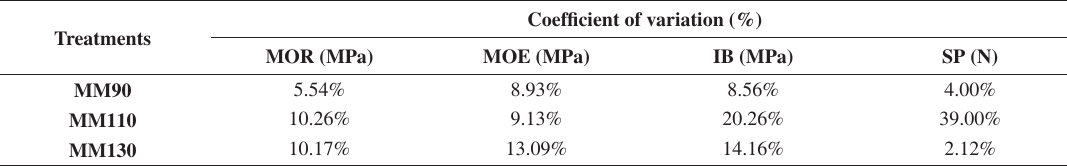
The same letters indicate that the treatments did not differ statistically after the one-way ANOVA followed by the Tukey post-hoc test (p <0.05). Table 3. Coefficients of variation of the mechanical properties of the particleboards.